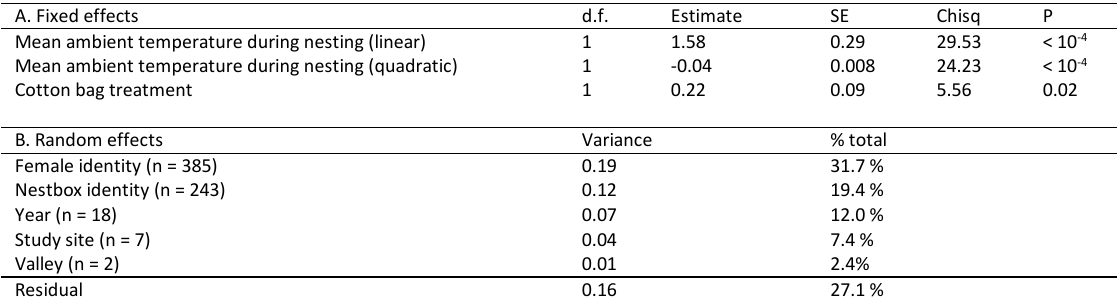
Table 2. Within-year variation in parasite load per chick in blue tit nests infested by hematophageous Protocalliphora larvae, in relation to mean ambient temperature during the nestling stage ( i.e. in the period when parasite larvae develop into blue tit nests) and cotton bag treatment ( i.e. presence or absence of a cotton bag around the nest). Results from the final linear mixed effects model, obtained after forward selection from an initial set of models with nest thickness ( i.e. height), cotton bag treatment, egg-laying date, female age, and average ambient temperature and rainfall during the nestling stage as explanatory variables. Year, valley, study site, nestbox identity, and female identity were included as random effect factors.